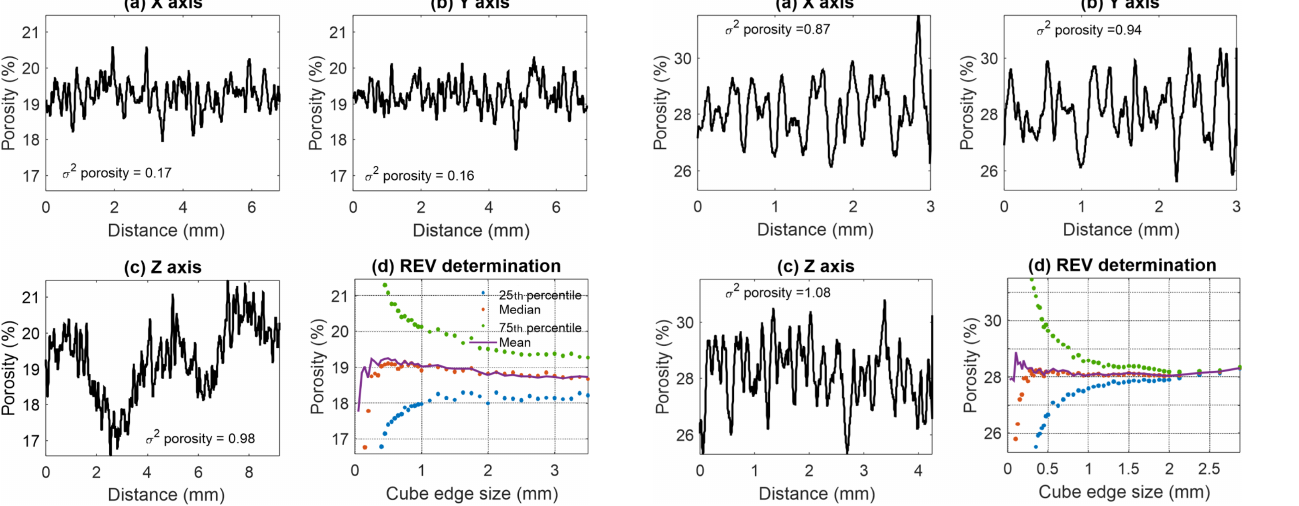
Figure 11. Determination of REV in S1. One-dimensional porosity profile of S1 slices evaluated in the (a) x direction, (b) y direction and (c) z direction. (d) Classic REV analysis. Investigated volume size is 6 . 8 × 6 . 9 × 9 . 2mm 3 .